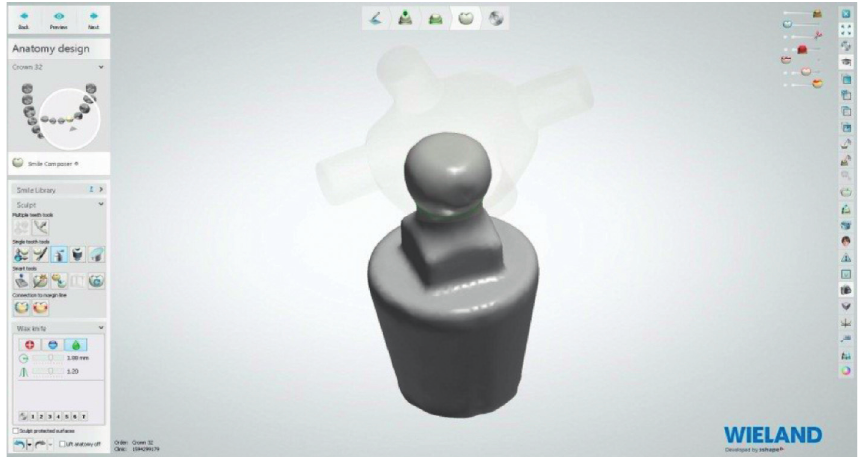
Figure 2: Scanned image of ball abutment analog.